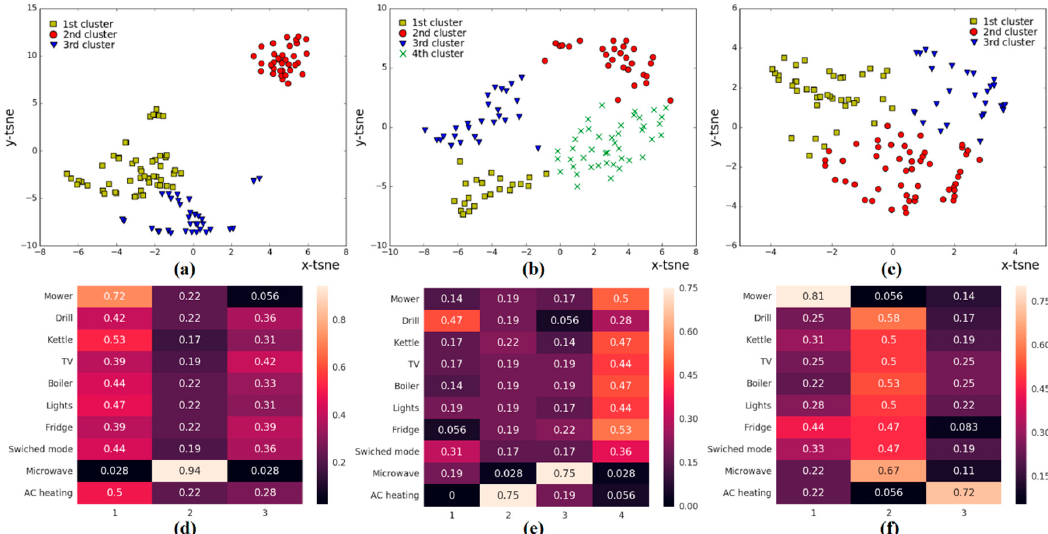
Figure 8. Clustering solutions of PQ parameters progress on SoC 50% with the calculated probabilities of appliances being part of the particular cluster: ( a , d )—FREQ with appliance probabilities, ( b , e )—THDV with appliance probabilities and ( c , f )— voltage (V) with appliance probabilities.